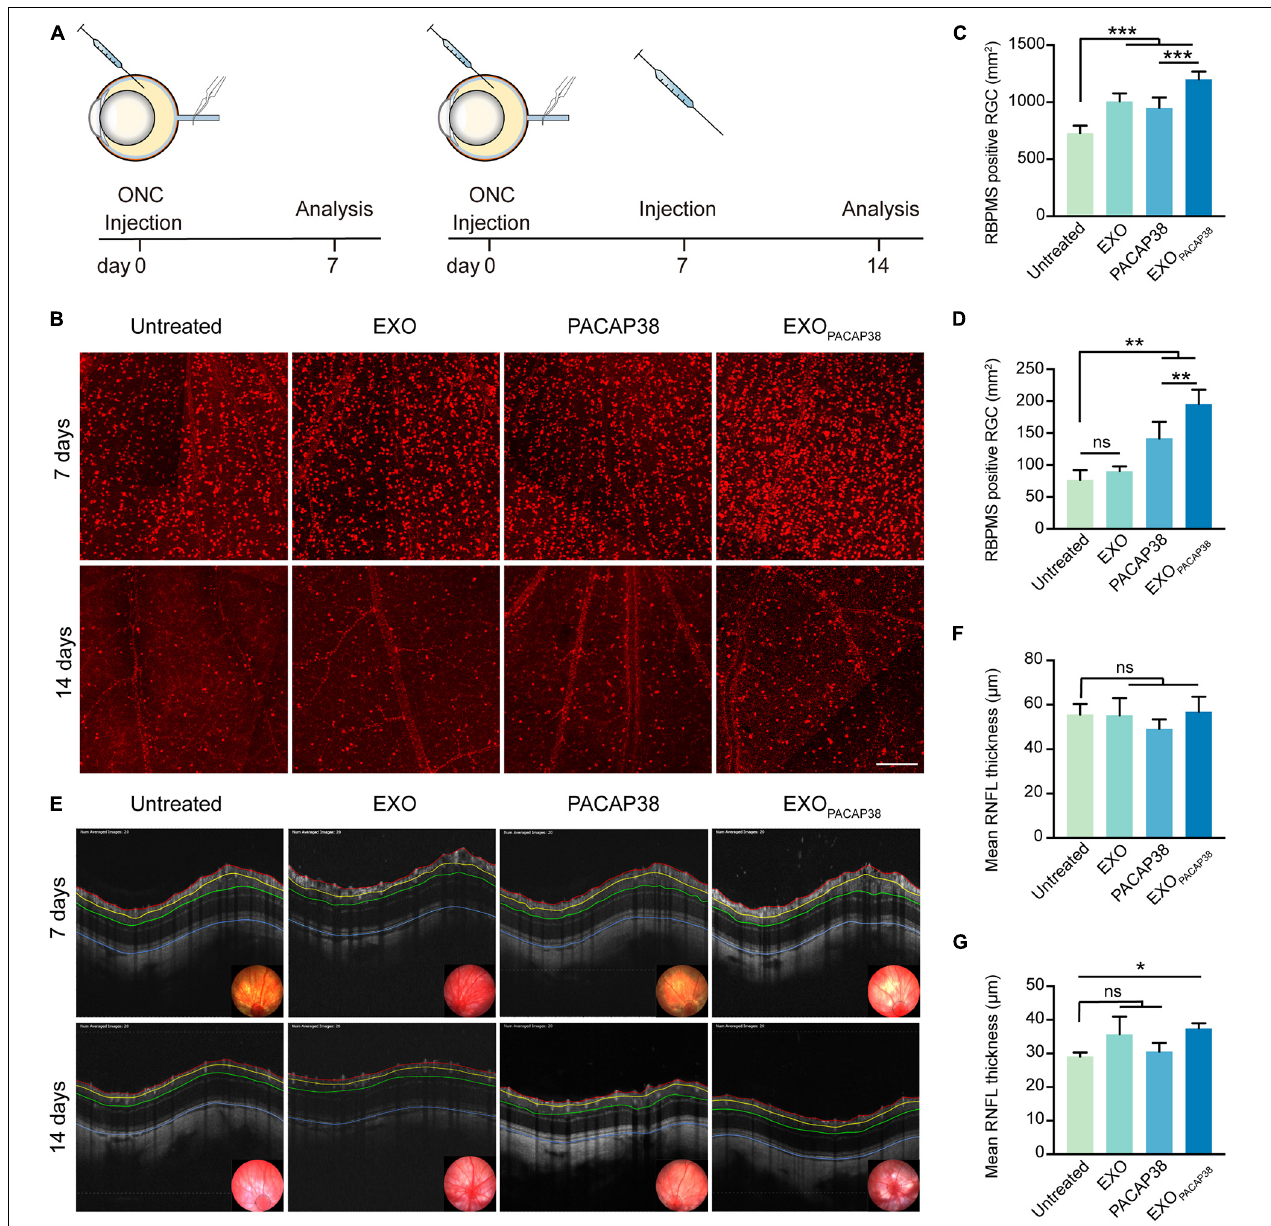
FIGURE 2 | Examination of the survival of RGCs in EXO PACAP 38 -treated rat retinas after ONC. (A) Experimental timeline. ONC was performed on rats followed by intravitreal injection of EXOs, PACAP38, and EXO PACAP 38 . After 7 days, some rats were sacrificed. The remaining rats were given a second injection and sacrificed at 14 days after injury. (B) Representative fluorescence images of RBPMS-labeled RGCs in a 1-mm 2 region of the retina at 7 and 14 days after injury, divided into the untreated, EXO-treated, PACAP38-treated, and EXO PACAP 38 -treated groups (scale bar = 200 µ m). (C) Quantitative analysis of the number of RGCs at 7 days after injury ( n = 4–5; values are mean ± SEM, one-way ANOVA, *** P < 0.001). (D) Quantitative analysis of the number of RGCs at 14 days after injury ( n = 4; values are mean ± SEM, one-way ANOVA, ** P < 0.01). (E) Representative OCT images showing the thickness of different layers of the retina within a range of 3,600 µ m in circumference with the optic disc as the center (black circle) at 7 and 14 days after injury, divided into the untreated, EXO-treated, PACAP38-treated, and EXO PACAP 38 -treated groups. RNFL refers to the distance between the red and yellow lines. (F) Quantitative analysis of the mean RNFL thickness ( µ m) of rats at 7 days after injury ( n = 3, values are mean ± SEM, one-way ANOVA). (G) Quantitative analysis of the mean RNFL thickness ( µ m) of rats at 14 days after injury ( n = 3; values are mean ± SEM, one-way ANOVA, * P <